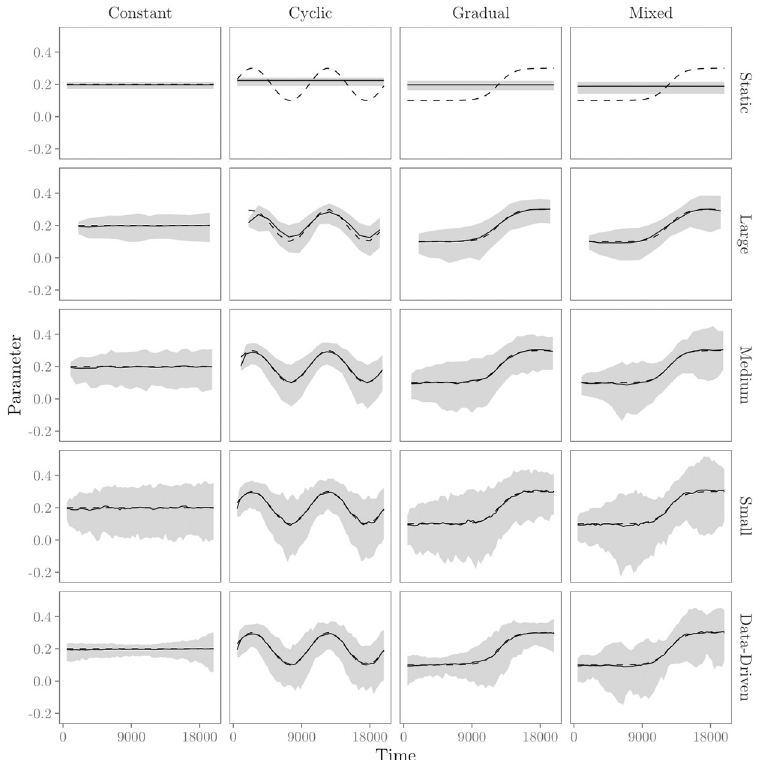
Fig 4. Results from the evaluation of the (moving window) REM for the ‘transitivity’ effect. Rows show results for estimation of the ‘transitivity’ effect with the ‘static’ REM, large (4000 t ), medium (2000 t ), small (1000 t ), and data-based window widths, respectively. Columns show results for estimation of the ‘transitivity’ effect in the four time-varying effects scenarios. Solid lines represent the mean estimated parameters over 200 datasets over time. The gray area represents the range with 95% of the estimates for the 200 datasets. Dashed lines represent the parameters used for data generation.